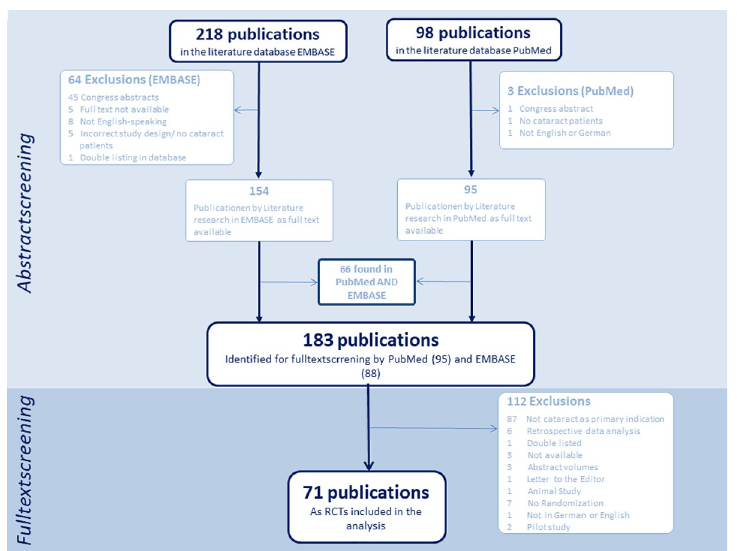
Fig 2. Cataract flow chart. Flow chart on screening for publications of trials on cataract treatment.